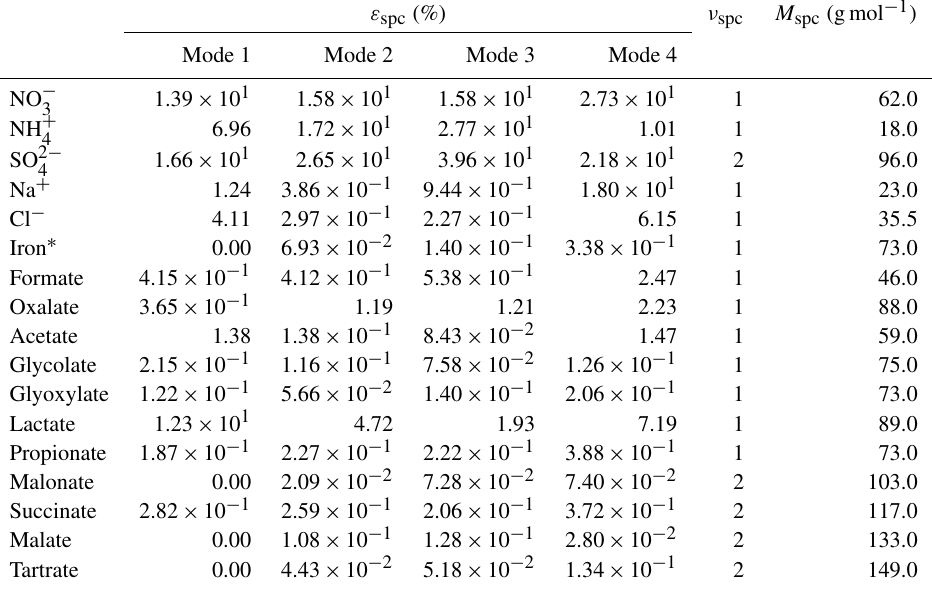
Table 3. Chemical composition of aerosol particles. Each species is given with its contribution to the soluble mass in each mode ( ε spc ) , its molar mass ( M spc ) and the number of ions into which it may dissociate ( ν spc )